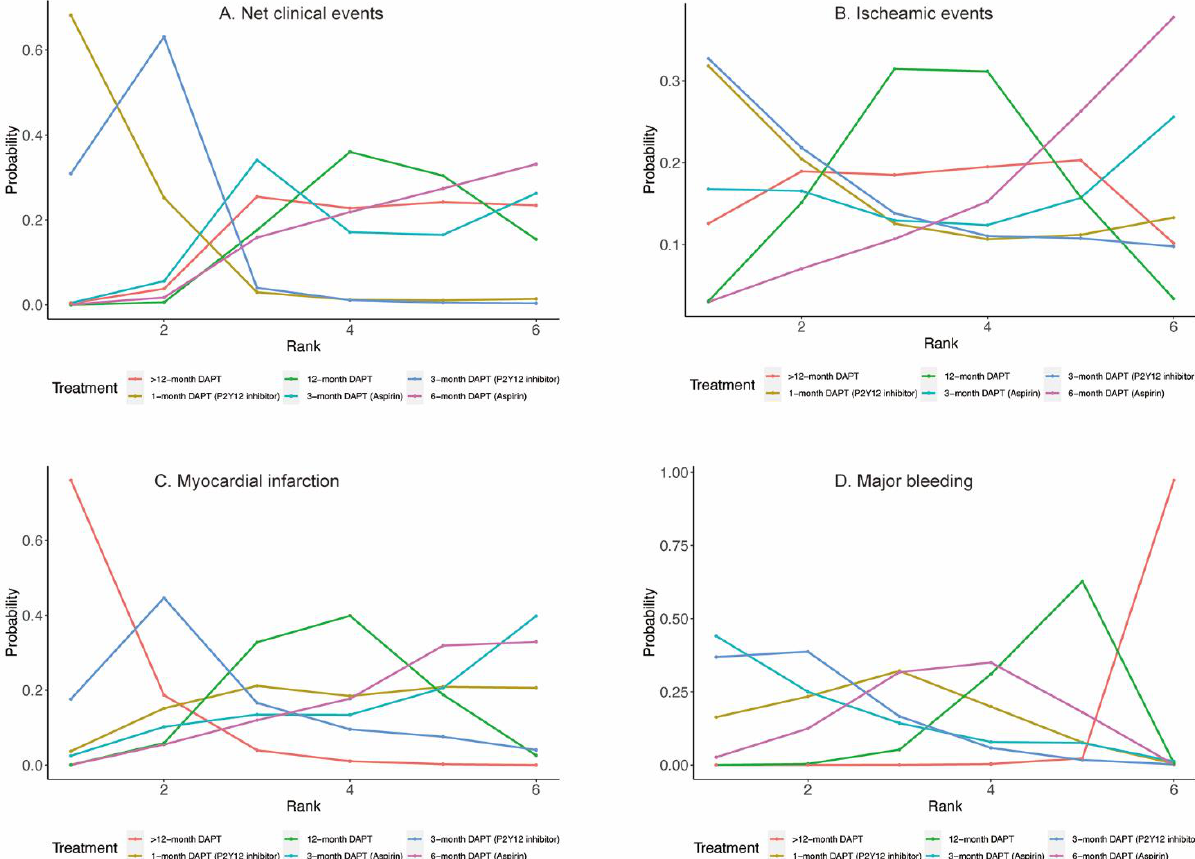
Figure 3. Rankograms for Primary Outcomes.